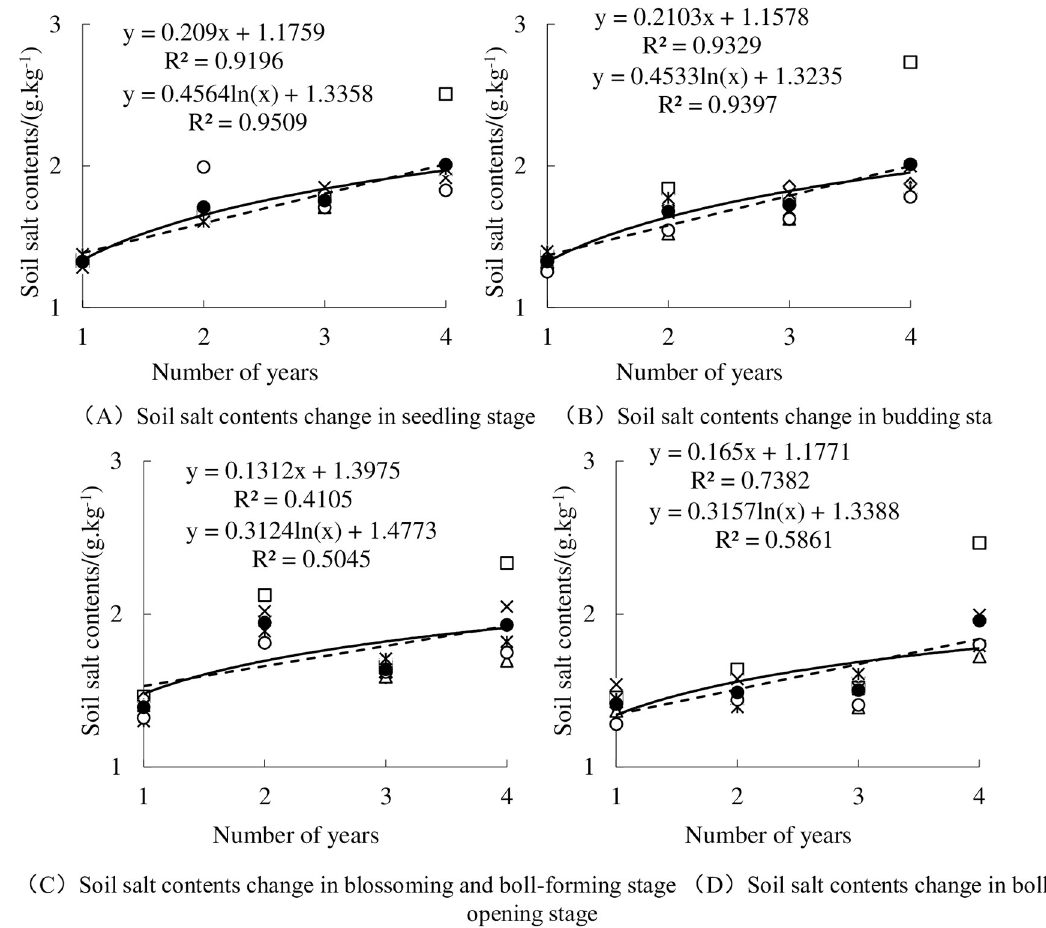
Fig 3. Salinity changes on soil depth of 0-100cm with irrigation time for differents cotton growth stage in 2012–2015.